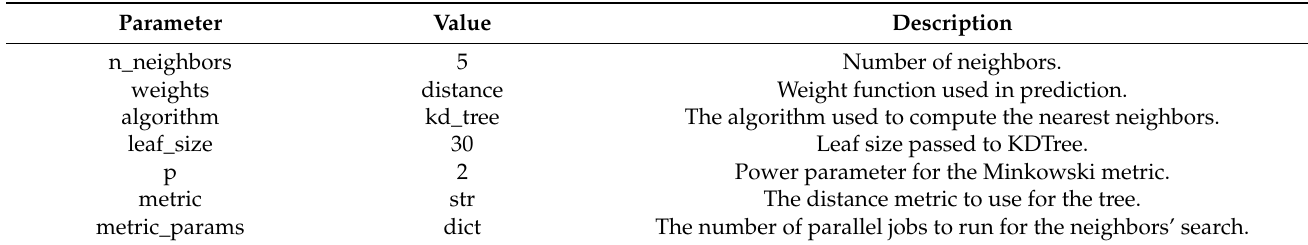
Table 8. K-Nearest Neighbor algorithm parameters [61].